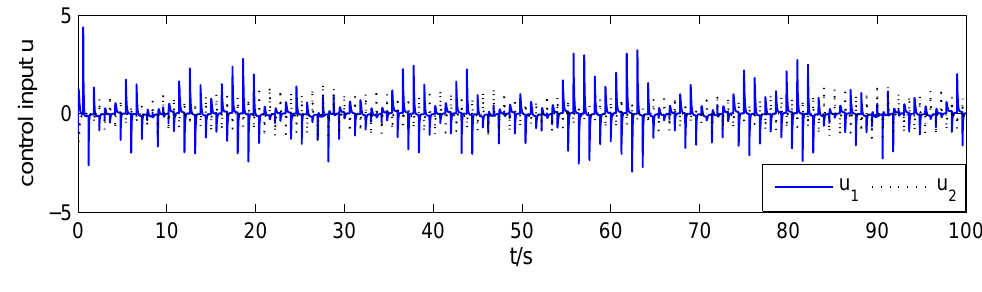
Figure 4. Control signal u = ( u